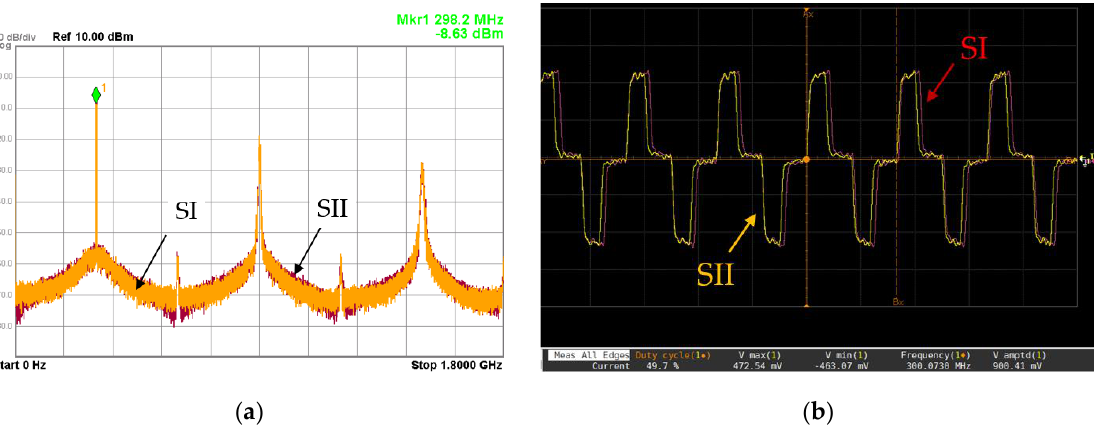
Figure 11. Comparison of measured waveforms for SI and SII. ( a ) Measured output spectrum; ( b ) measured time domain waveforms.